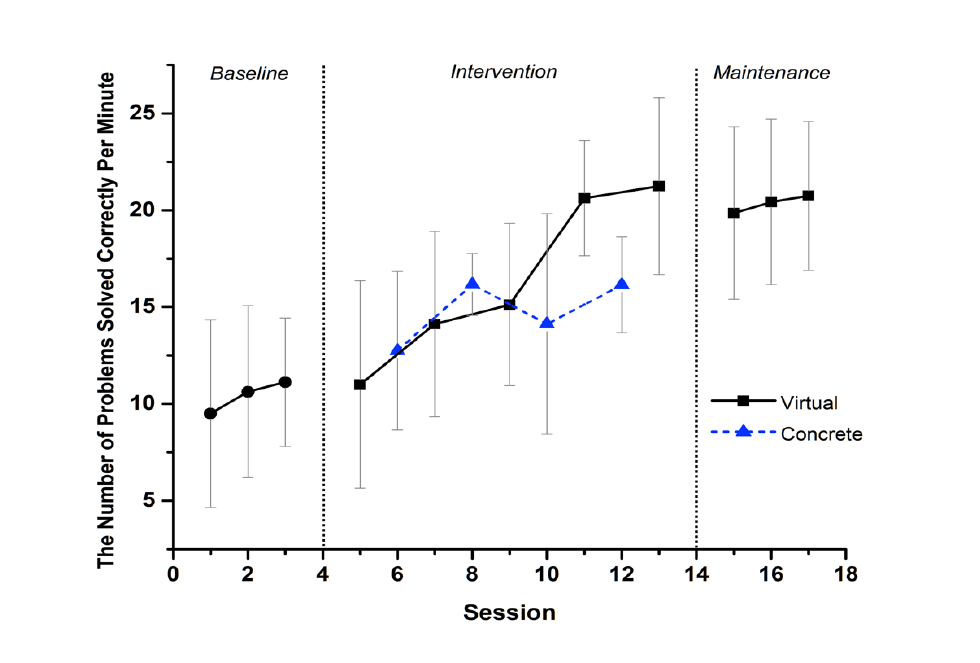
Figure 2: Average Math Fact Fluency in One-Digit by One-Digit